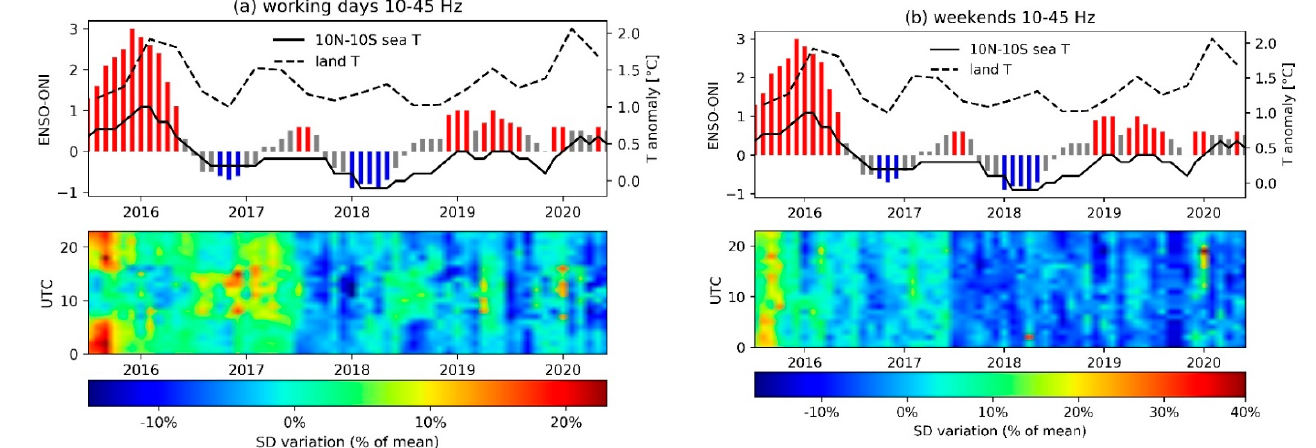
Figure 9. SR intensity anomalies measured at Portishead over the period 2015-2020 during working days ( a ) and weekends ( b ). The top panel shows the ENSO phases, along with 10N-10S SST anomaly and global land temperature. The SD relative variation is shown in the lower panel. The color scale represents the deviation (%) of each bin value from the corresponding mean of absolute values based on the 5-year period.